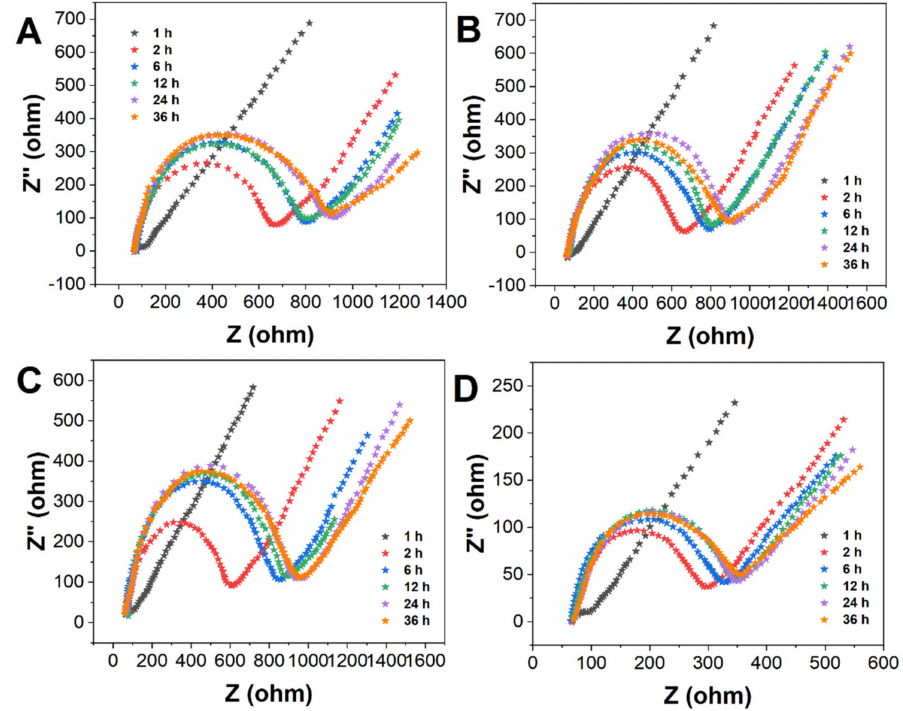
Figure 2. EIS plots of MPA/ME/Au with MPA volume percentage of ( A ) 100%, ( B ) 50%, ( C ) 25%, and ( D ) 10%.